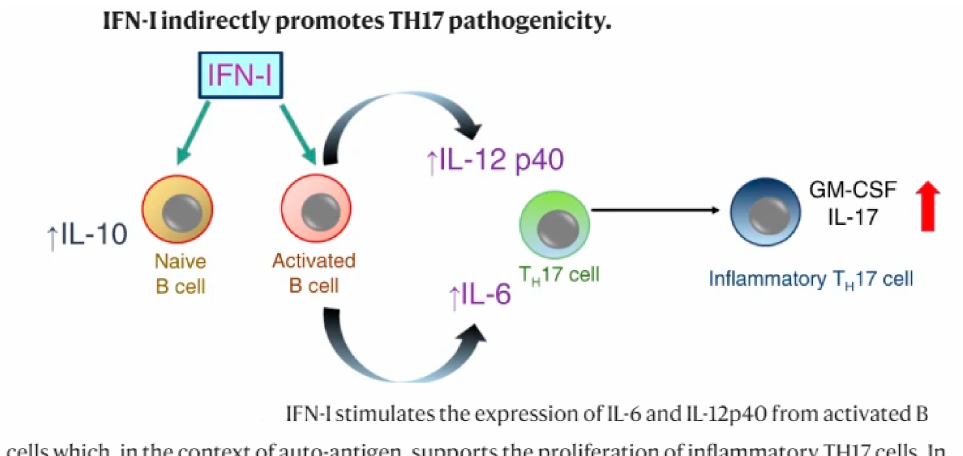
Figure 7. INF-I and TH17 pathogenicity